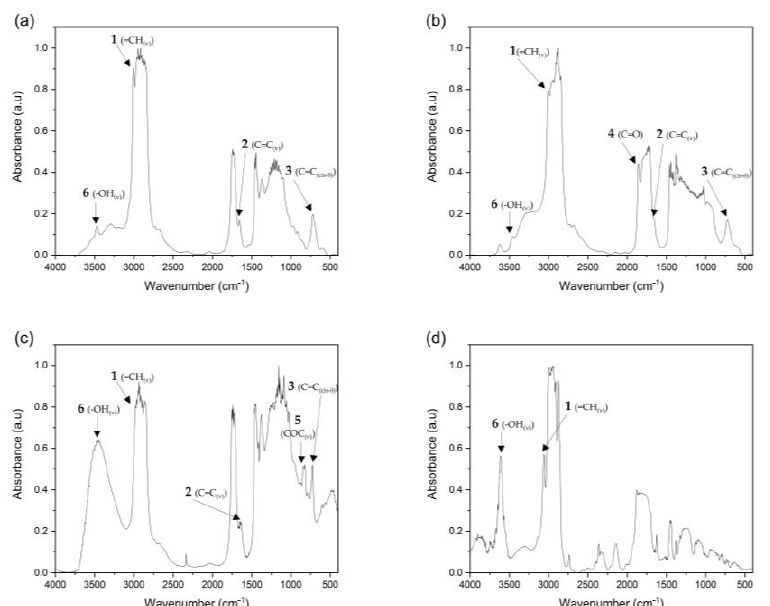
Figure 6. FTIR spectra of the different elements in the samples, ( a ) virgin hemp oil, ( b ) maleinized hemp oil (MHO), ( c ) epoxidized hemp oil (EHO) and ( d ) methyl nadic anhydride (MNA).